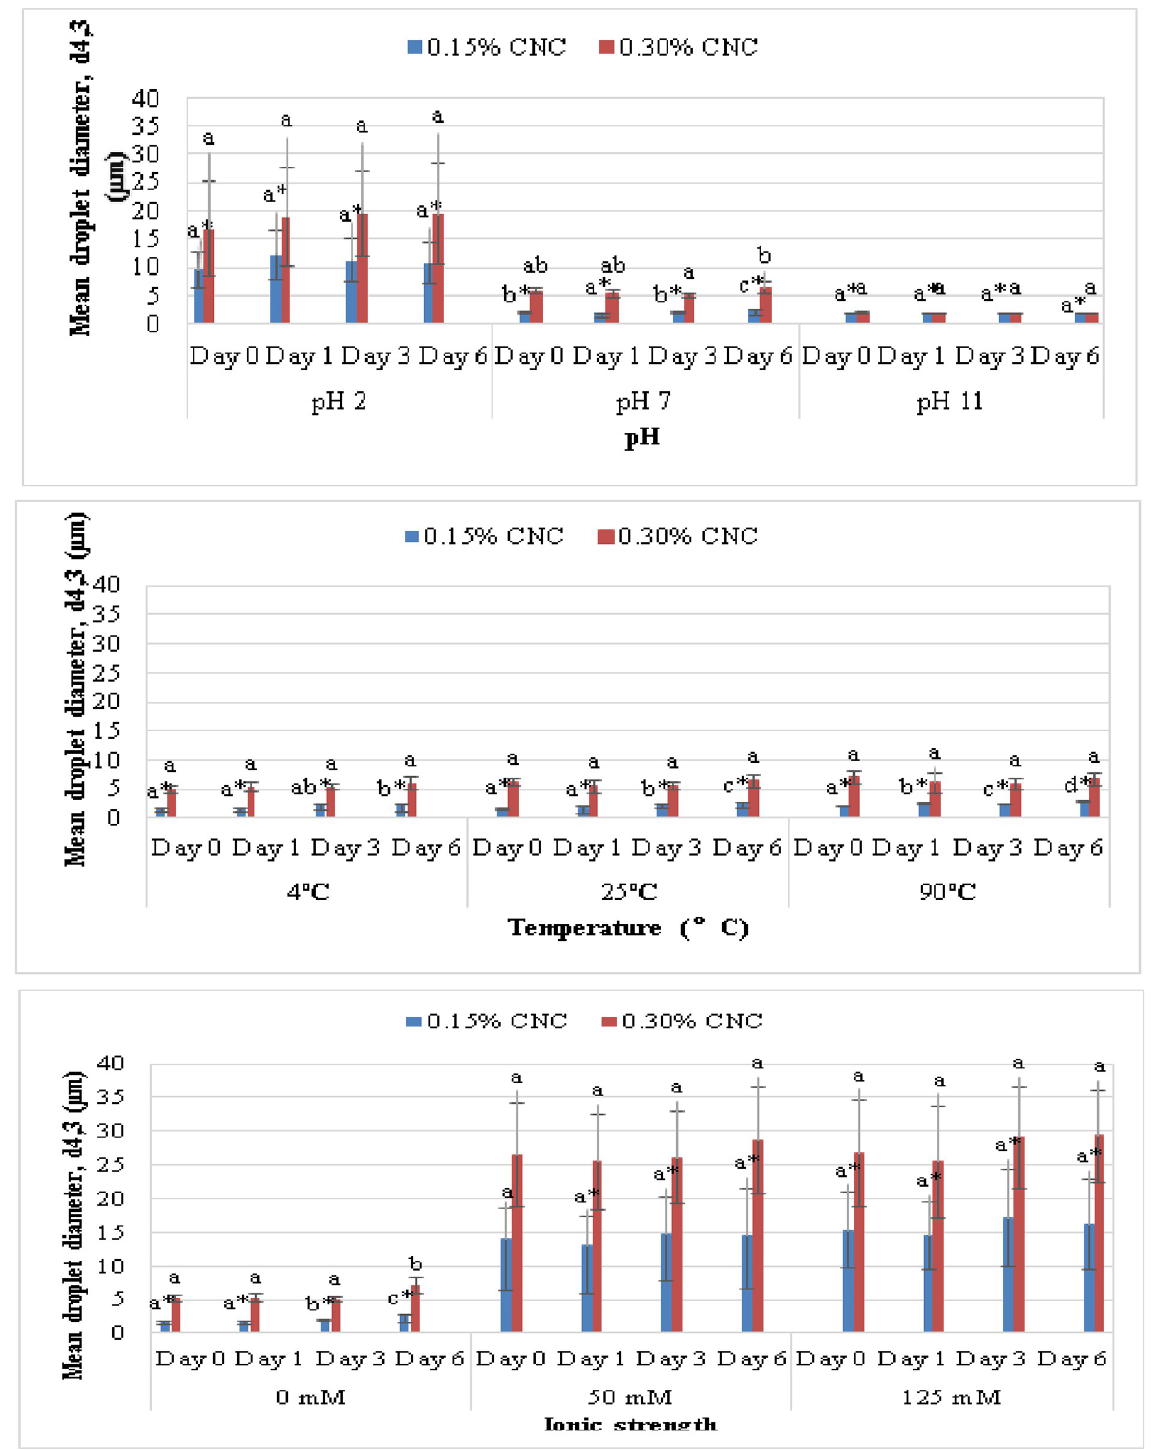
Fig 7. top) Mean droplet diameter, d4,3 ( μ m) against pH (2, 7, 11); centre) temperature (4˚C, 25˚C and 90˚C); bottom) ionic strength (0mM, 50mM and 124mM) for CNC0.15-PE and CNC0.30-PE over 6 days of storage. abc represents values within the same conditions (concentration, pH, temperature and ionic strength) with same letters were significantly different (p < 0.05) across different days.